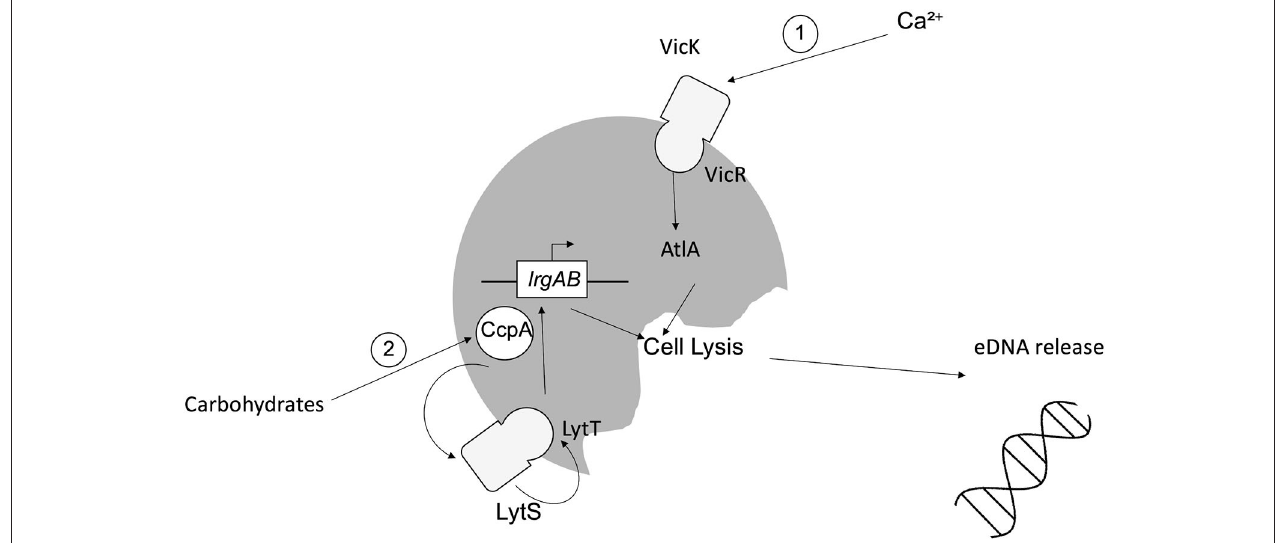
FIGURE 1 | Mechanisms of lysis-dependent eDNA release from Streptococcus mutans . (1) Fluctuations in the availability of calcium induce the activity of the sensor kinase VicK, which in turn induces the activity of intracellular response regulator VicR via phosphorylation, leading to the induction of AtlA, autolysis and eDNA release. (2) Carbohydrates (e.g., sucrose/glucose) induce the activity of CcpA, which modulates TCS LytST, ultimately causing the upregulation of lrgAB and subsequent expression of the LrgA/B holin-like proteins, inducing cell lysis and eDNA release.